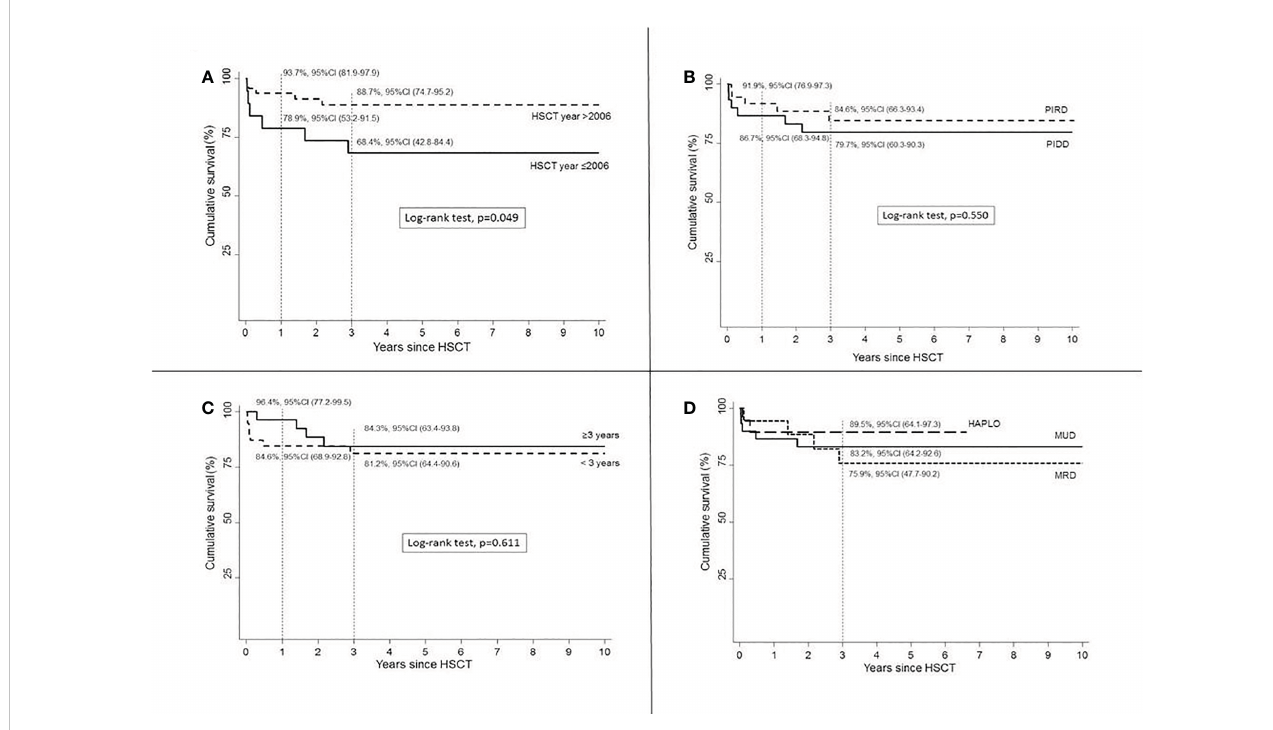
FIGURE 2 Survival according to HSCT year (A) , disease group (B) , age at HSCT (C) , and donor (D) .